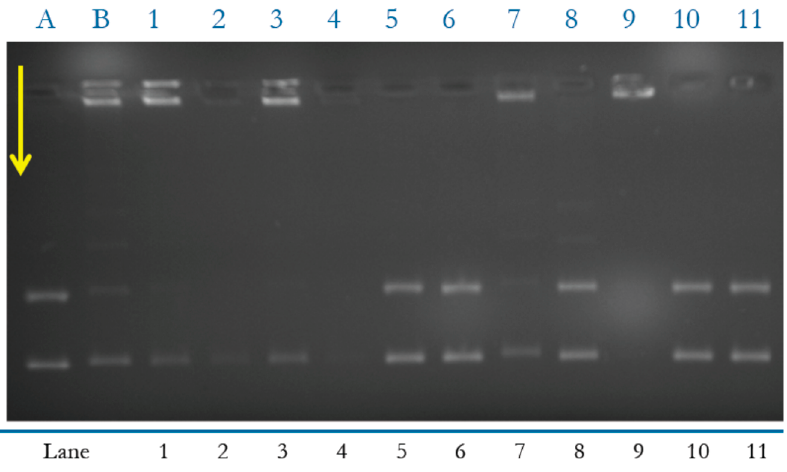
Figure 3. Screen of topoisomerase II inhibitory activity of the ellipticine derivatives at 100 µM. A = Positive Control (kDNA+ATP+Topo II); B = Negative Control (kDNA + ATP + Topo II + 100 µM Ellipticine); Consequent lanes all screened at 100 µM: 1 = Ellipticine 1; 2 = 9-Methoxyellipticine 2; 3 = 9-Formylellipticine 19; 4 = 9-Hydroxyellipticine 4; 5 = 8; 6 = 9; 7 = 13; 8 = 15; 9 = 16; 10 = 17; 11 = 11.